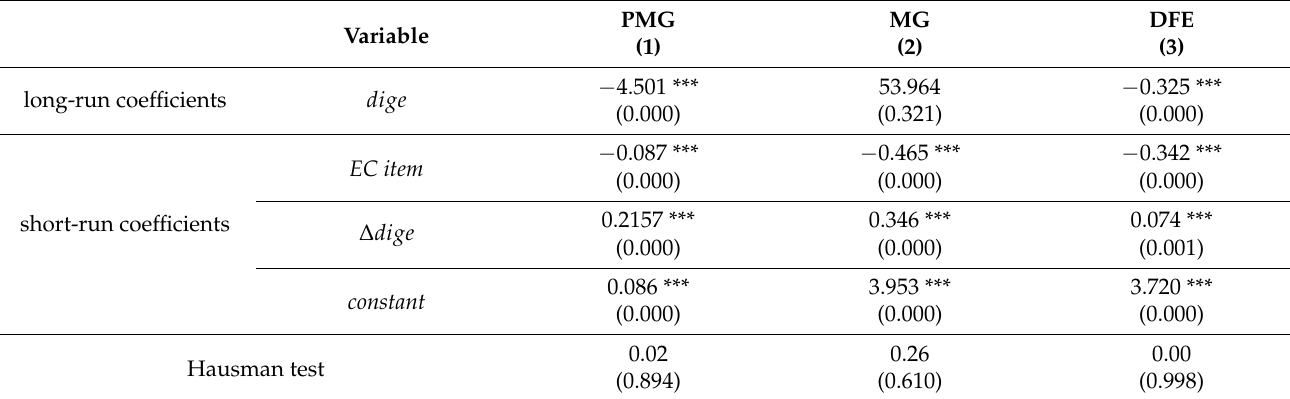
Table 6. Robustness test